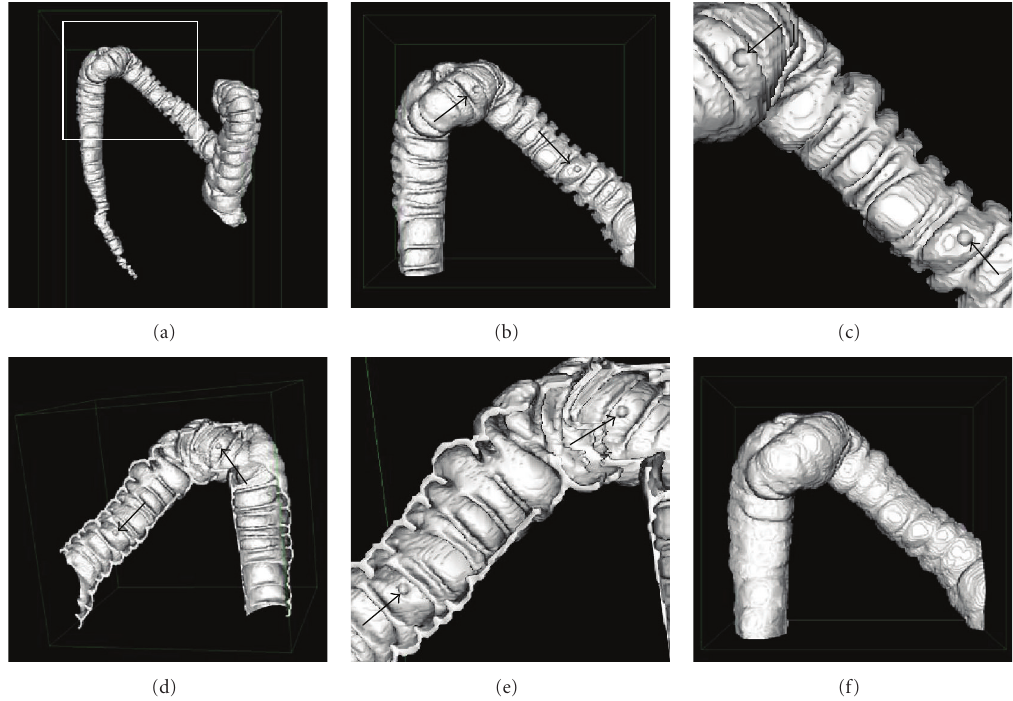
Figure 6: Surface rendering of the original colon lumen with two digitally implanted polyps and its reference surface for digital eversion. (a) An outside view of the whole colon lumen, in which the portion defined by the frame is selected for the digital eversion, (b) a magnified view of the selected colon segment and the simulated polyps (arrows), (c) a magnified view of (b), (d) a bisected colon to show the inner surface and the simulated polyps (arrows), (e) a magnified view of (d), and (f) the reference surface for the digital eversion.